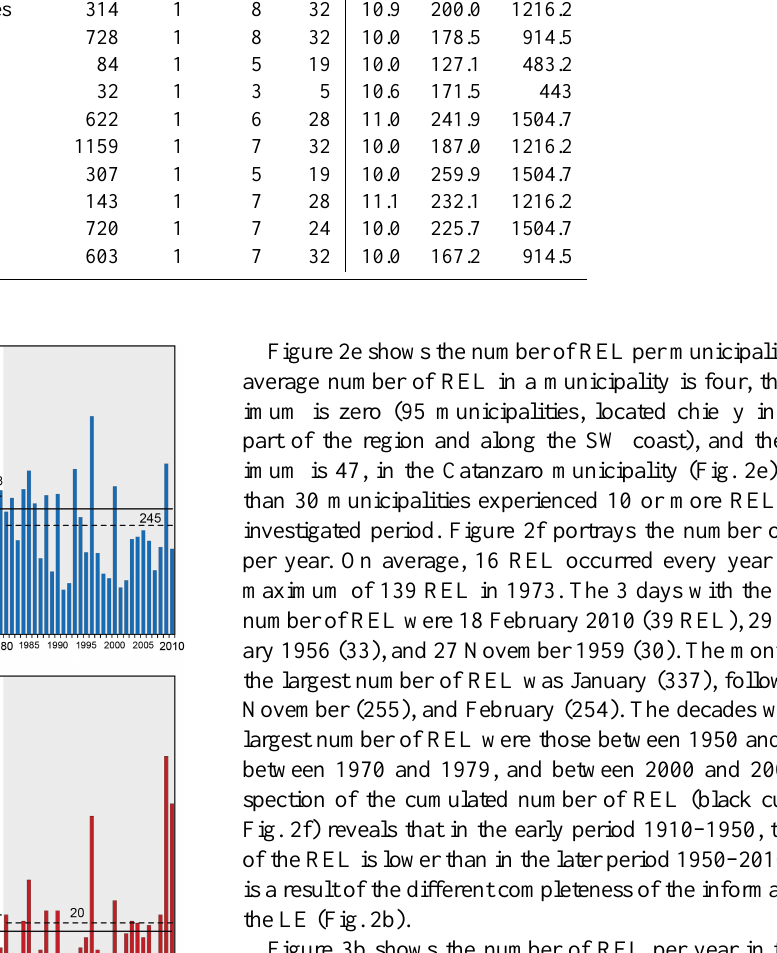
10.0 < E < 1504.7 mm (average 202.3 mm) (Table 1).